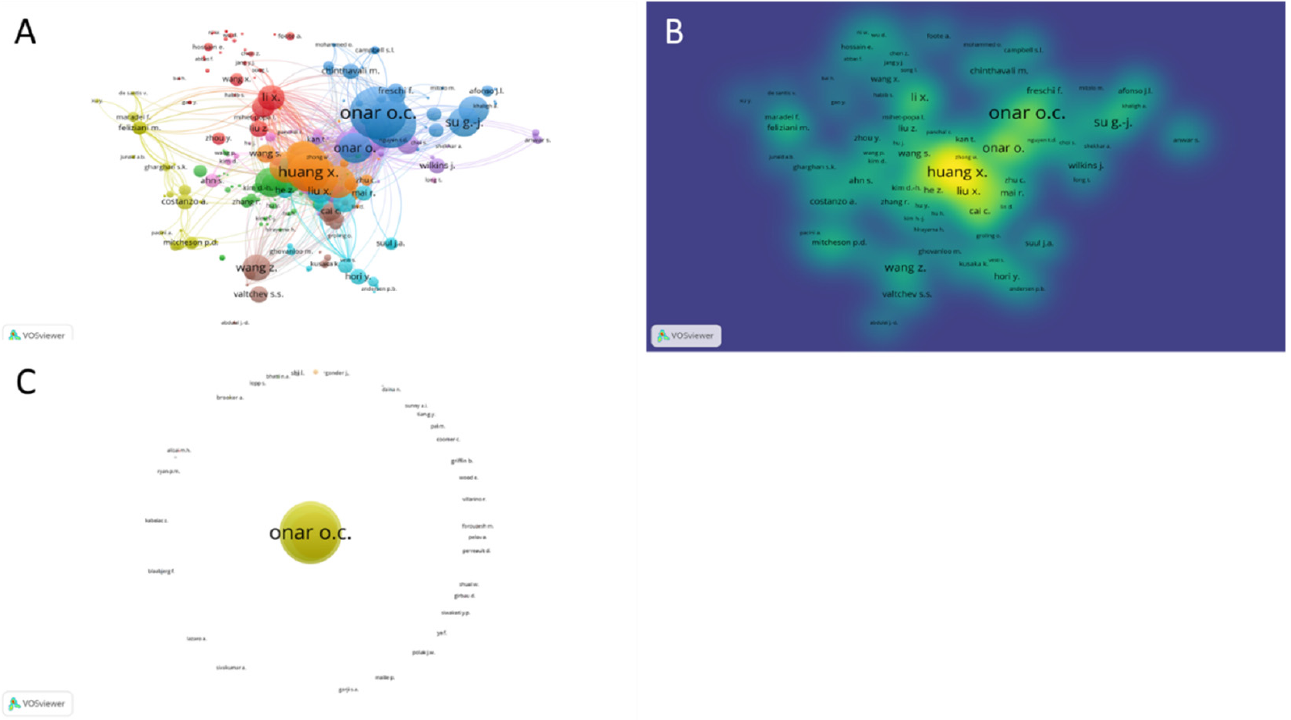
Figure 10. Citation network for authors ( A ), density map ( B ) and non-connected author map ( C ). The maps ( A , B ) show 300 connected authors (334 unconnected authors in C ) out of 3074 authors that met the threshold of 1 document and 50 citations per author. There were 9 clusters and 6224